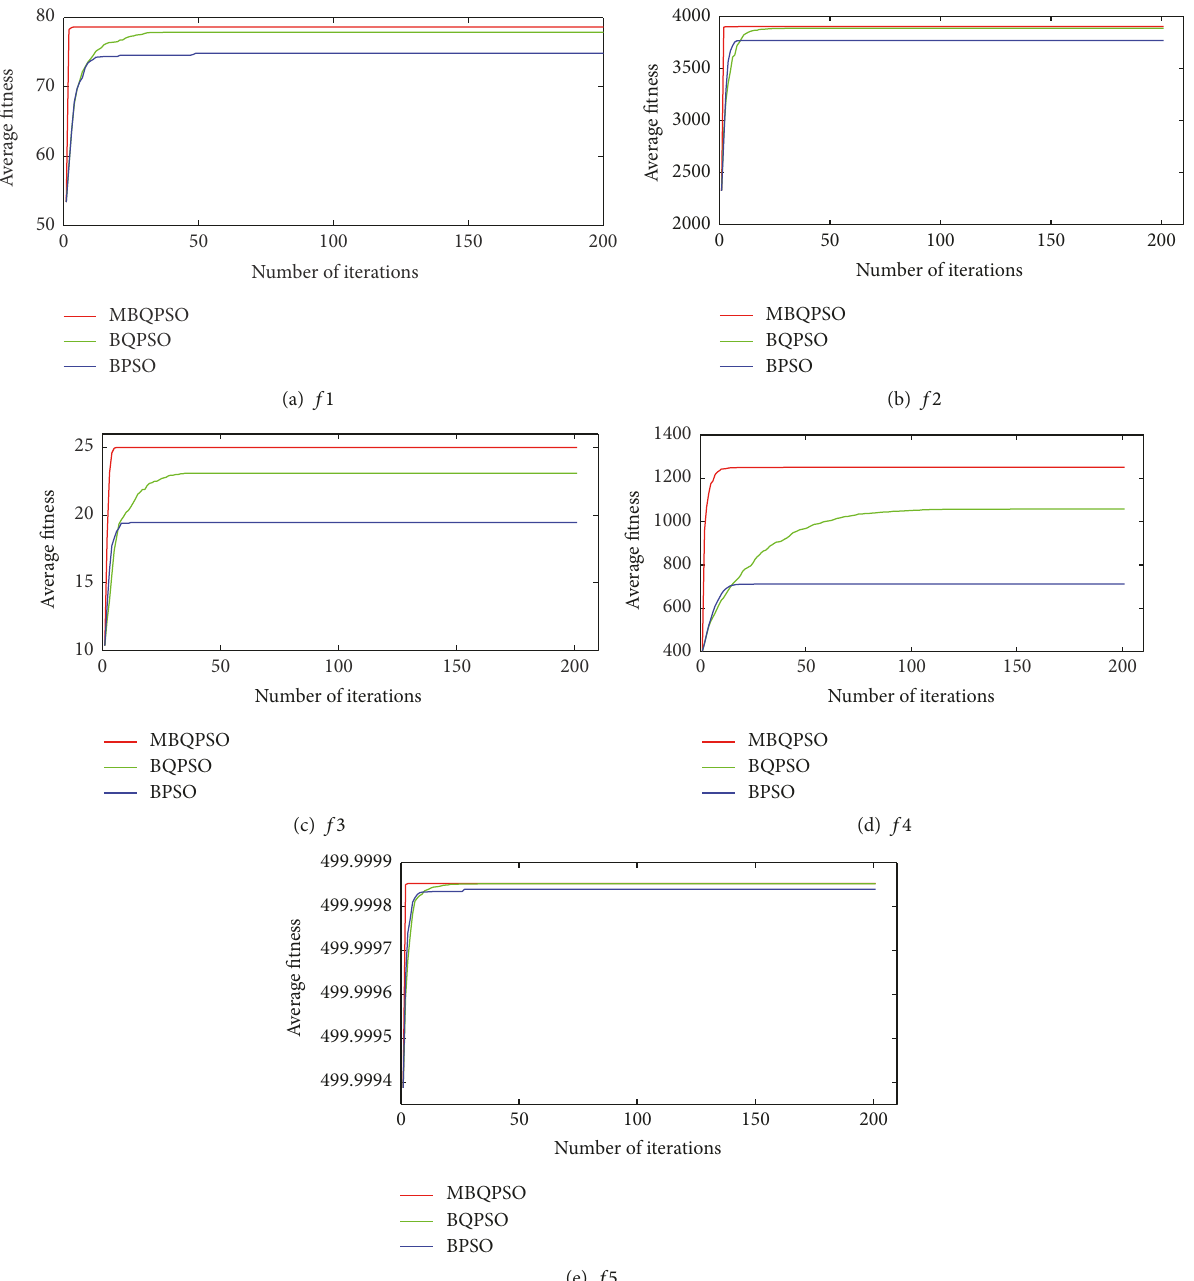
Figure 3: Comparison of the convergence curves of objective function values for different test functions with three optimization algorithms.